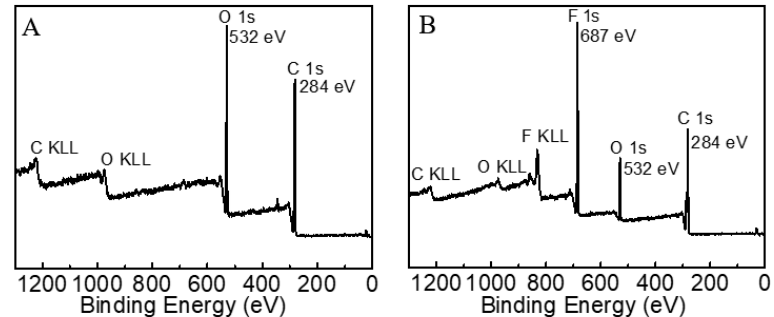
1250 Figure 9. FT-IR spectrum of OFAE-SA-BA. 2.2. XPS Analysis